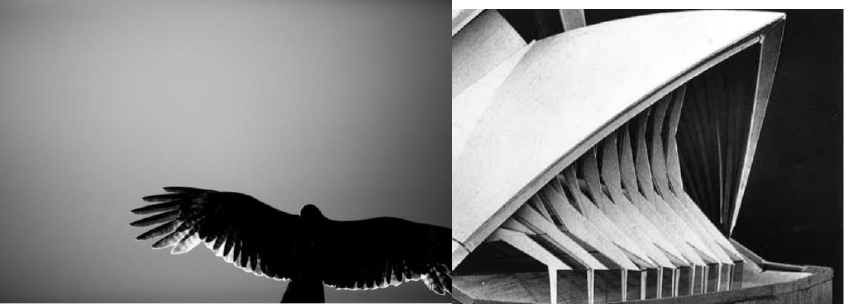
Figure 11. Left : image of a bird in flight, which Utzon used as a reference for the development of the facades (https://pxhere.com/es/photo/1224384; last accessed 2 December 2021). Right : glass wall design principle (Yellow Book, 1962); (www.records.nsw.gov.au; last accessed 2 December 2021)